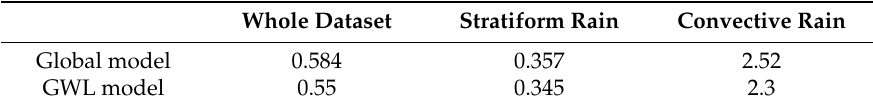
Table 2. Mean average error (MAE) in the rain rate R [mm · h − 1 ] calculated by the GWL Z–R model and the general Z–R relation. The values are given for the entire dataset and for each rain type separately.